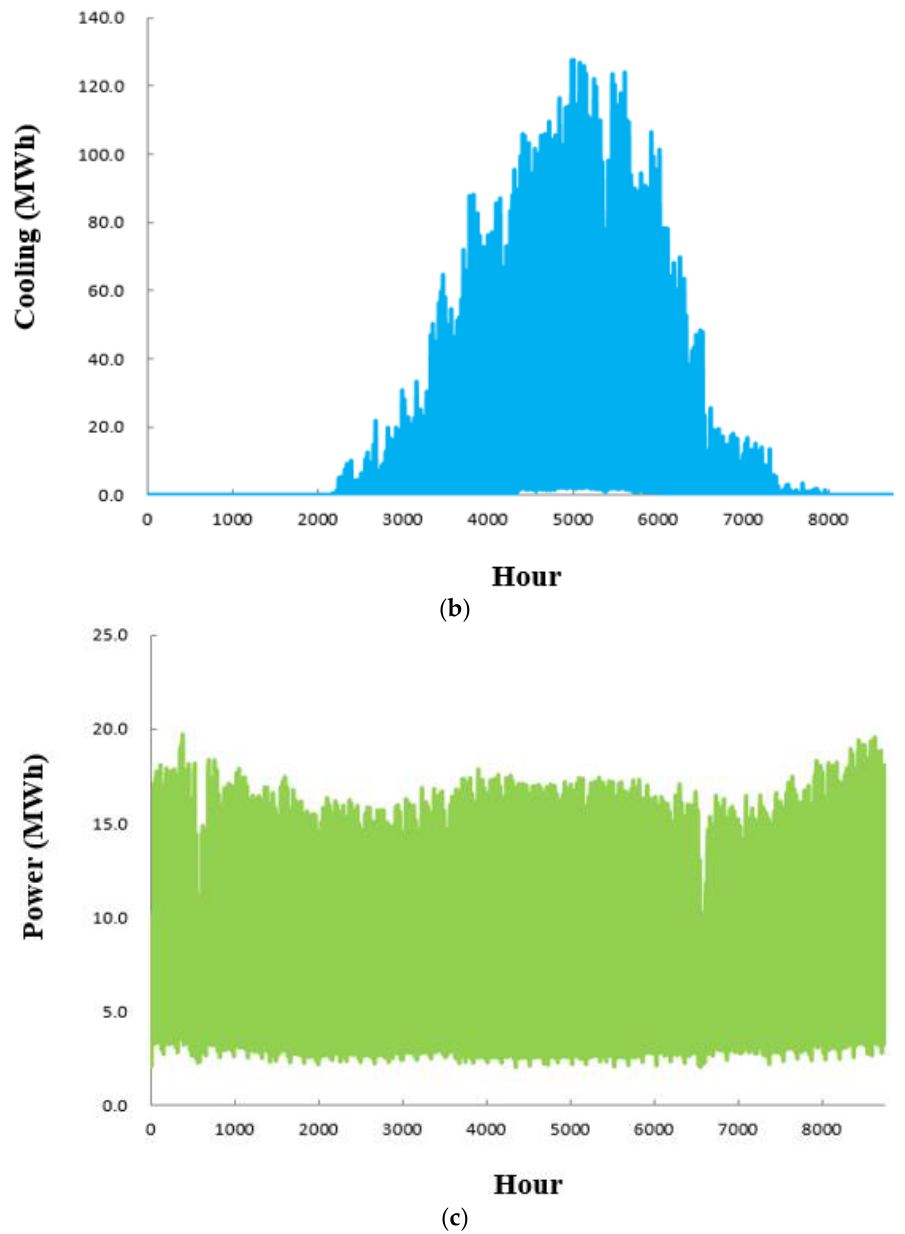
Figure 4. Example of annual hourly load profile from the load estimator. ( a ) Overall annual hourly heating load of the building. ( b ) Overall annual hourly cooling load of the building. ( c ) Overall annual hourly power load for the building.